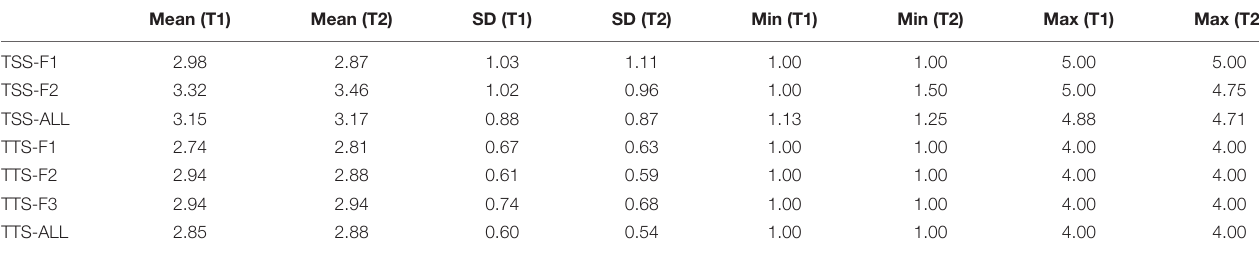
TABLE 12 | Descriptive statistics for the TSS and the TTS subscale and overall scale scores at Time 1 (T1, N = 122) and Time 2 (T2, N = 48). Mean (T1)